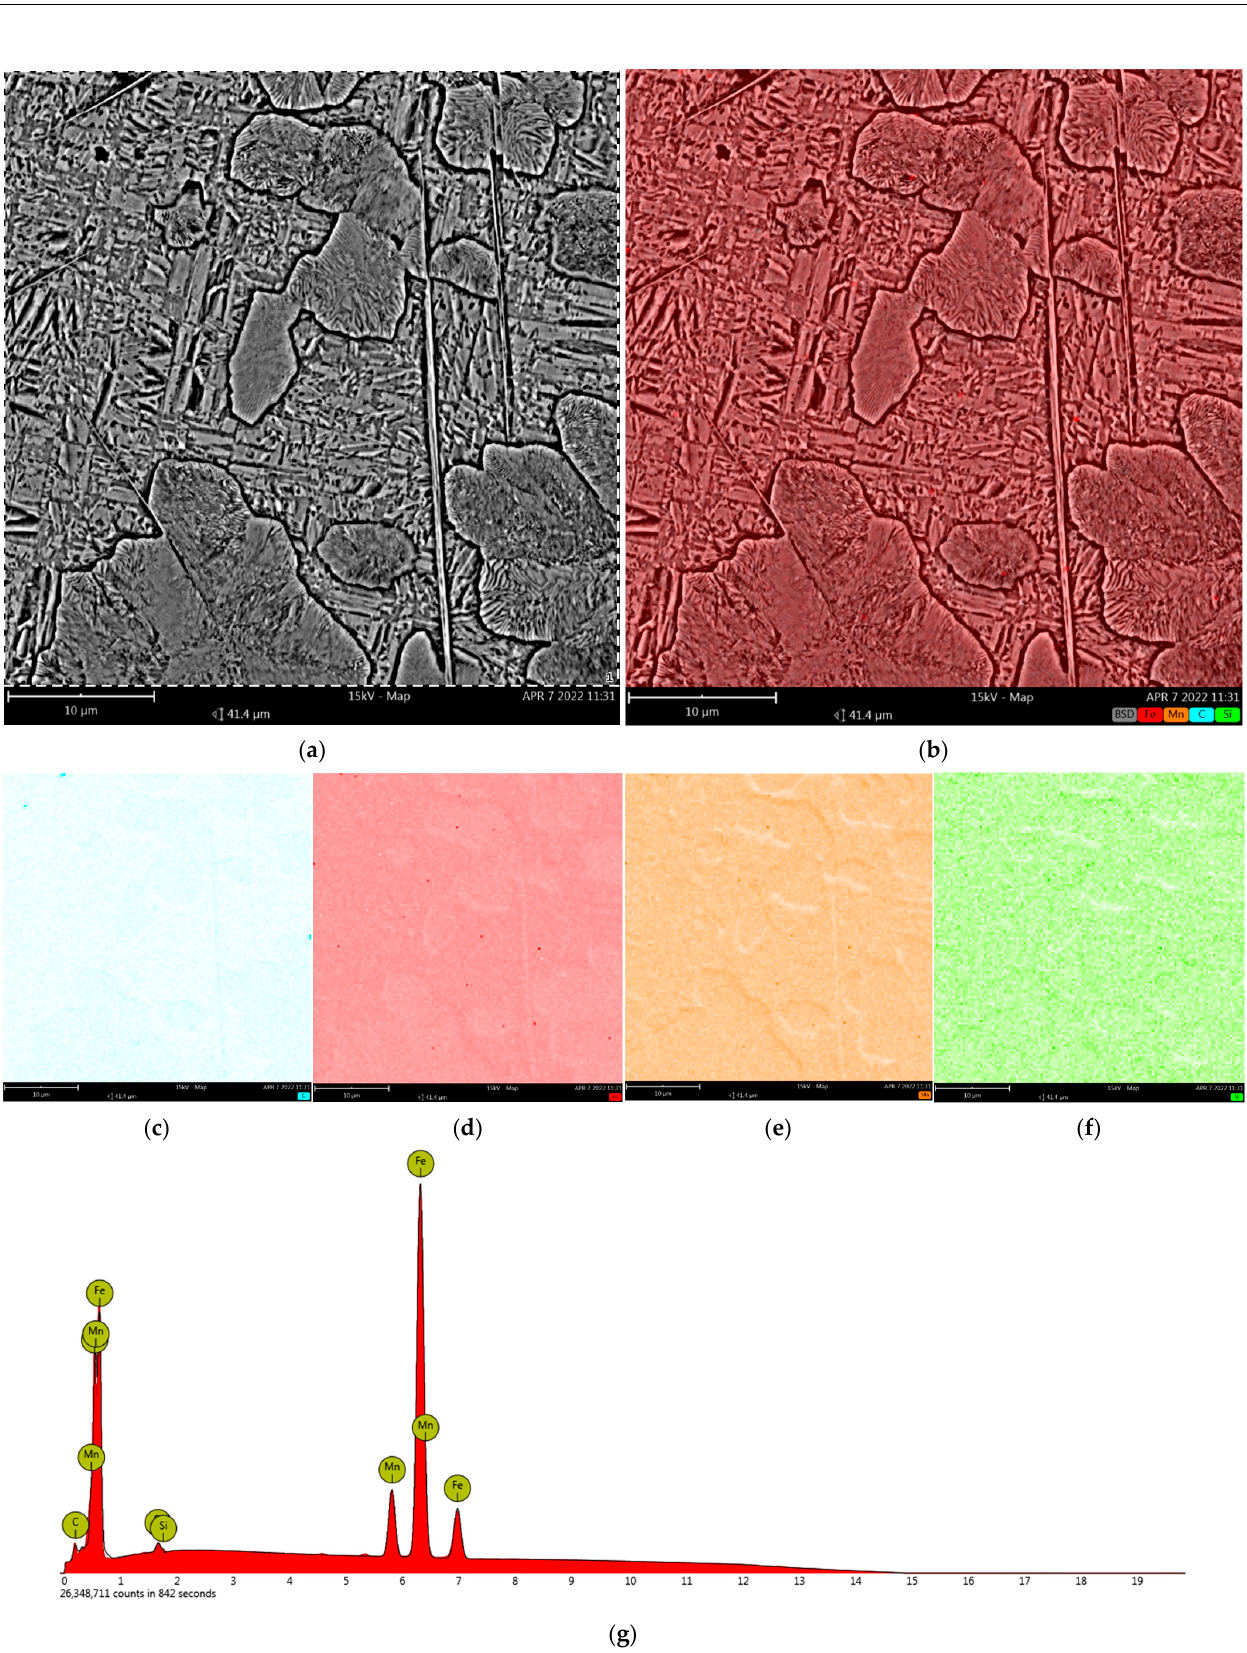
Figure 8. EDX surface microanalysis results: ( a ) area of analysis; ( b ) graphical distribution of the analysed elements; ( c – f ) the individual elemental distributions arranged sequentially as C, Fe, Mn and Si; ( g ) the energy spectrum of the X-rays obtained from the area analysed. SEM